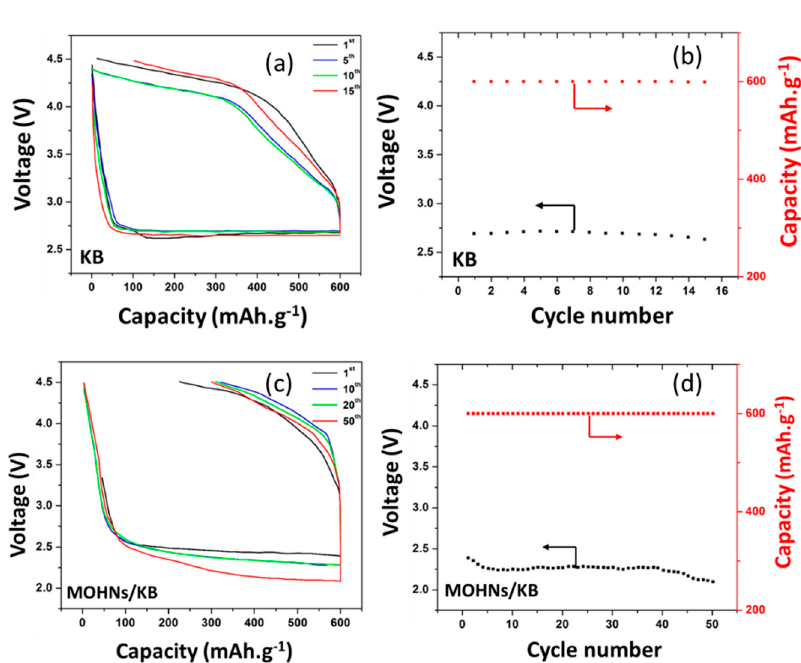
Figure 5. ( a ) The discharge–charge curves and ( b ) the cyclic stability of the KB cathode-based Li–O 2 battery; ( c ) the discharge–charge curves and ( d ) the cyclic stability of the MOHNs/KB cathode-based Li–O 2 battery. All tests of Li–O 2 batteries were subjected to a restrained specific capacity of 600 mAh·g − 1 and a specific current of 400 mA·g − 1 .